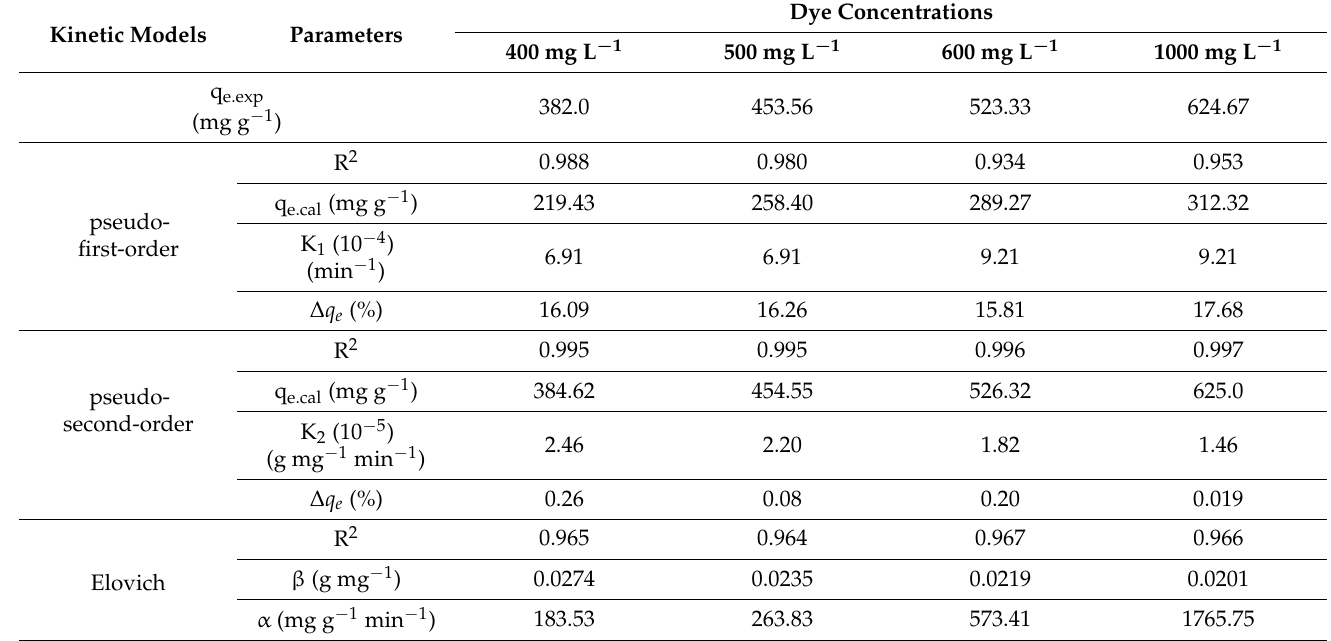
Table 3. Kinetic model constants and correlation coefficients for the adsorption of CR dye onto UCs at different dye